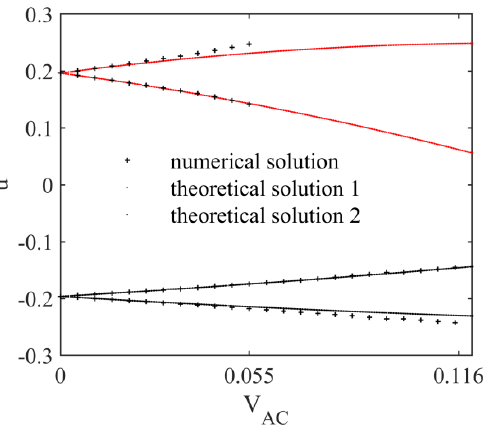
ω = 0.6. Figure 6. Variation of the periodic solutions with the amplitude of AC voltage when ω =